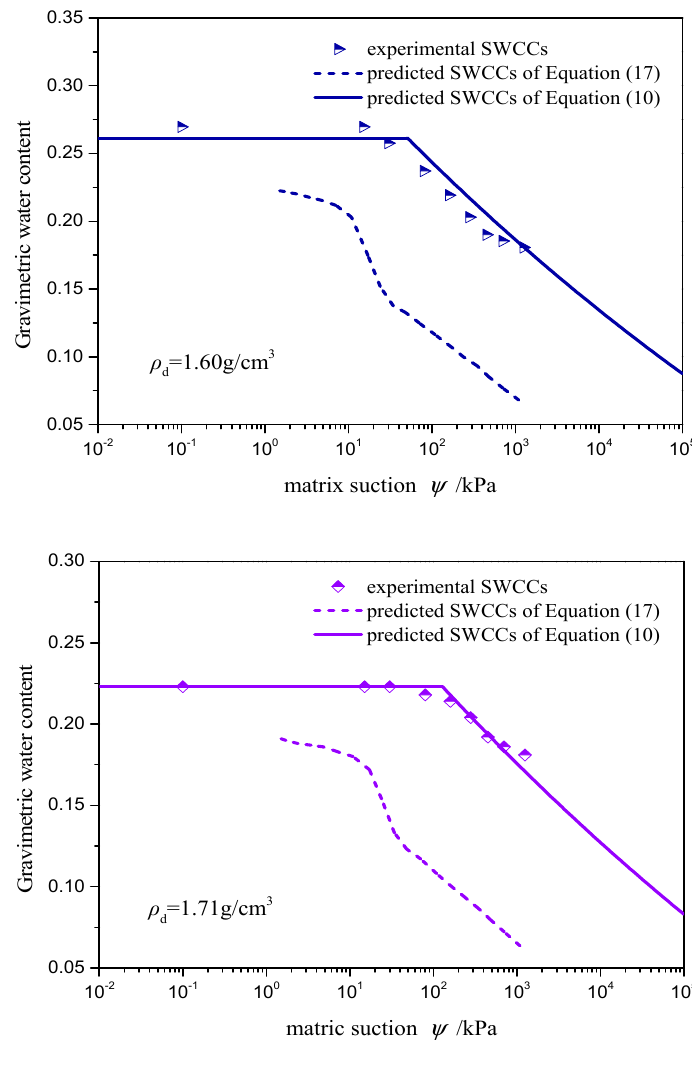
Figure 7. Comparison between experimental results and predicted SWCCs from Equation (15) and Equation (10).